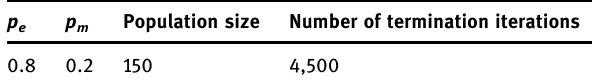
Table 1: Values of GA algorithm related parameters